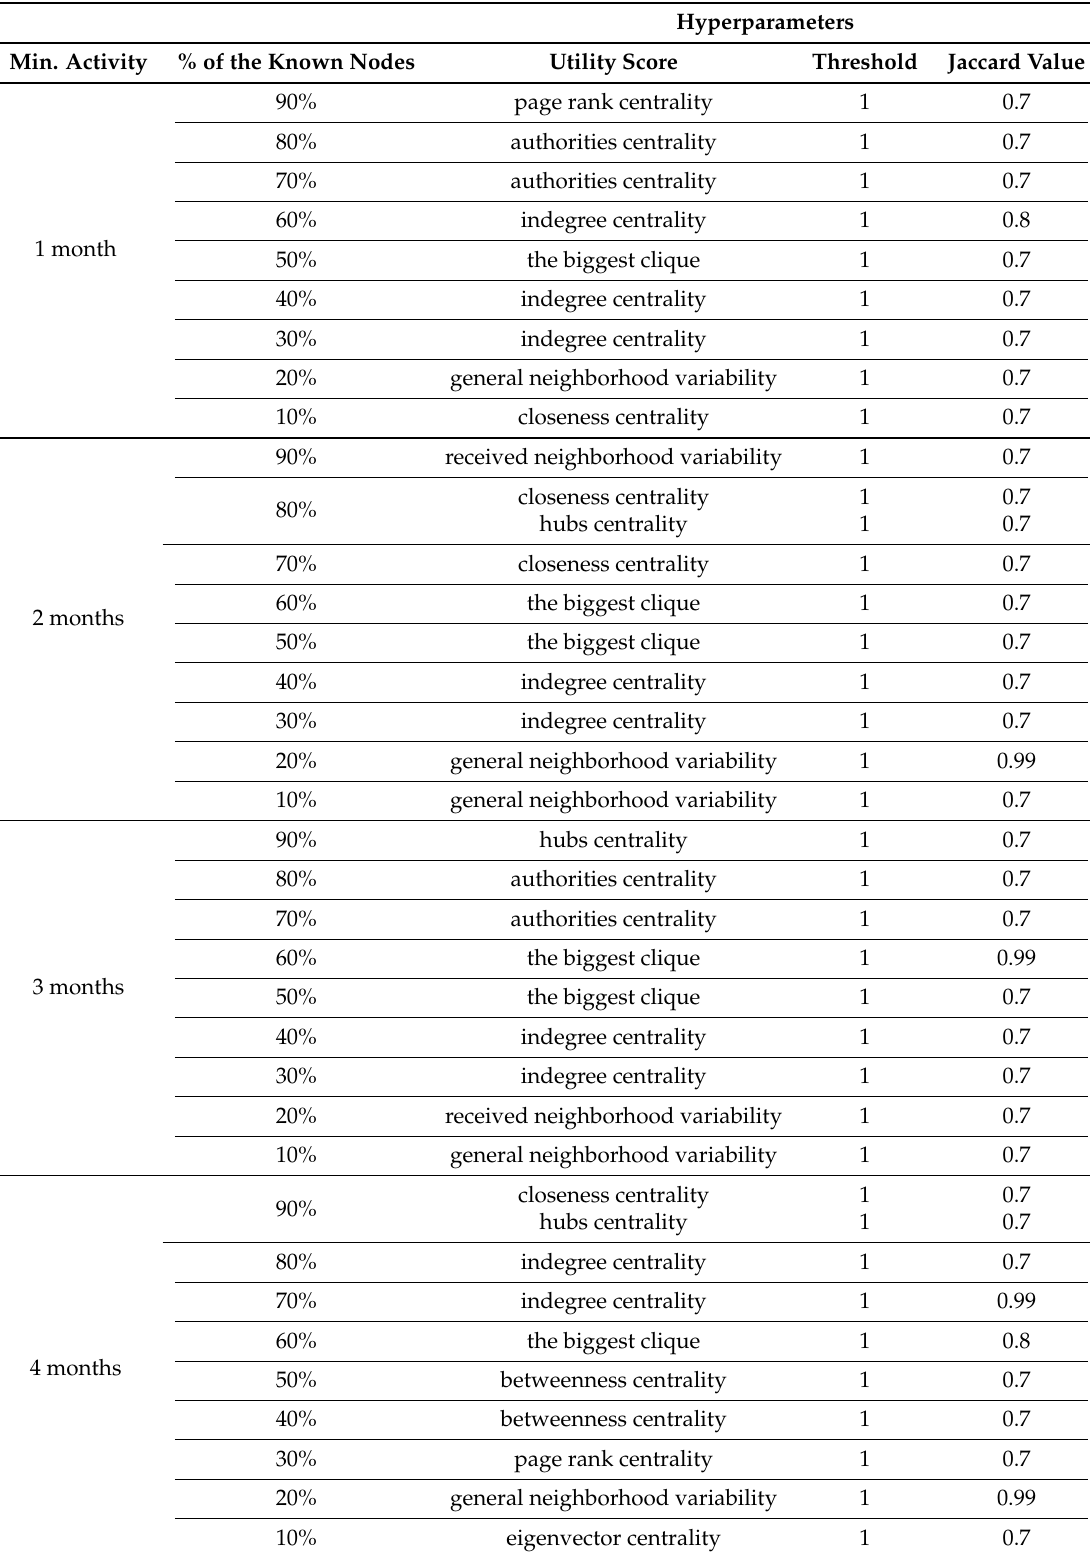
Table A30. The best values of the hyperparameters for the collective classification algorithm for the Enron dataset with two hierarchy